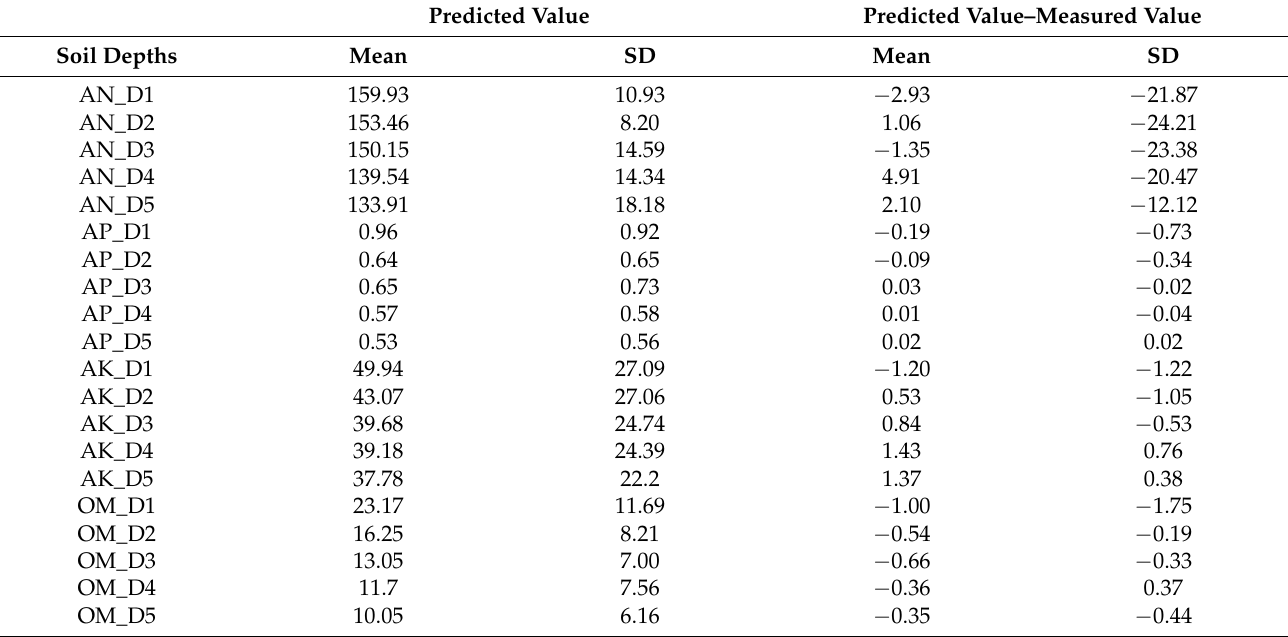
Table 6. Statistics of the predicted values for each soil layer. Predicted